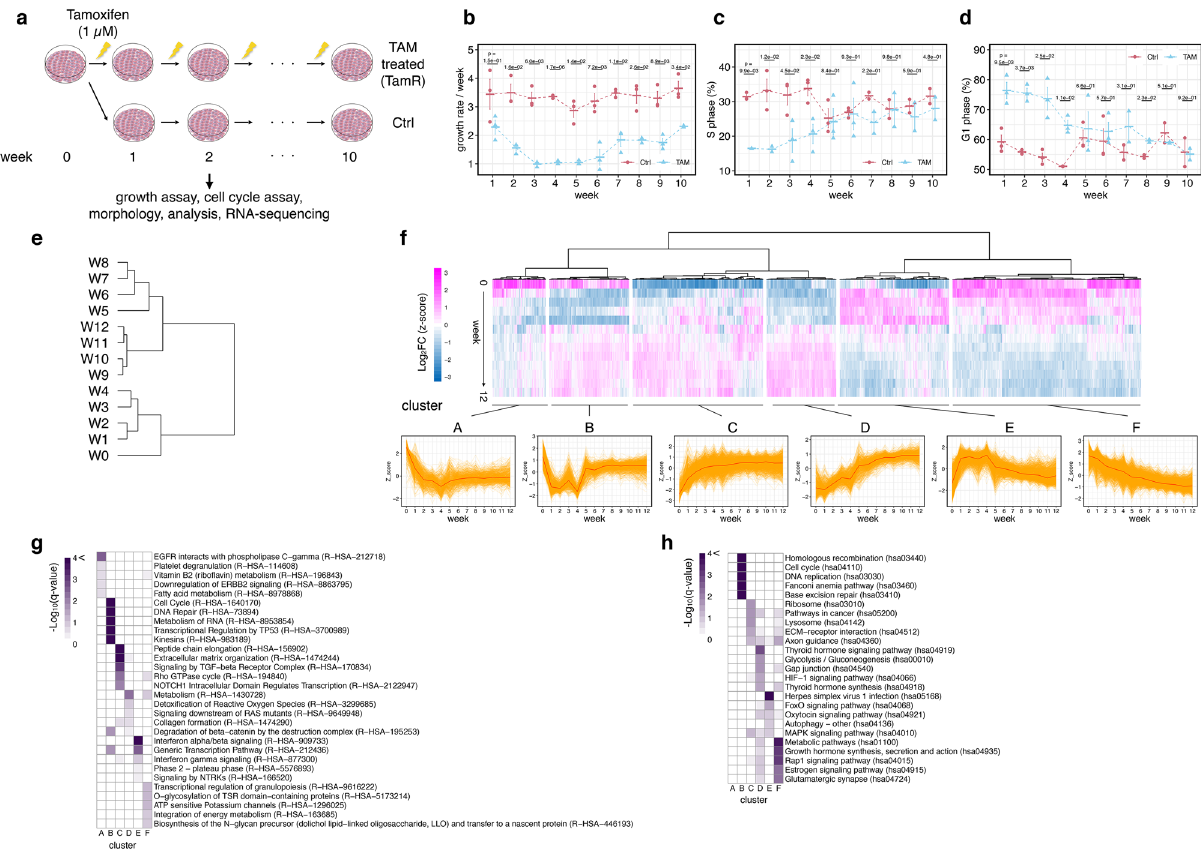
Figure 1. Functional analysis of gene expression patterns in human breast adenocarcinoma MCF-7 cells during the TAM resistance acquisition process. ( a ) Schematic overview of the experimental procedure. Each treatment was replicated five times. ( b ) Growth rate of TAM-treated and control (Ctrl) cells. Data represent mean ± standard error (SE, n = 3). ( c , d ) Ratio of S ( c ) and G1 ( d ) phase in TAM-treated and Ctrl cells. Data represent mean ± SE (n = 3 in week 1 to week 6, n = 2 in week 7 to week10). From ( b ) to ( d ), the data points are slightly shifted in the x-axis direction to improve the visibility and prevent overlapping of the Ctrl and TAM graphs, and p-values were calculated using two-tailed Welch’s test. ( e , f ) Cluster analysis of the z-scores of log2 fold change (log2FC) values by time points ( e ) and by genes ( f ). The bottom line graphs in ( f ) showed individual (orange) or median (red) of gene expression patterns. ( g , h ) Heatmaps of enrichment analysis data. The top five significant terms in the Reactome pathway database ( g ) and KEGG pathway database ( h ) in each cluster are